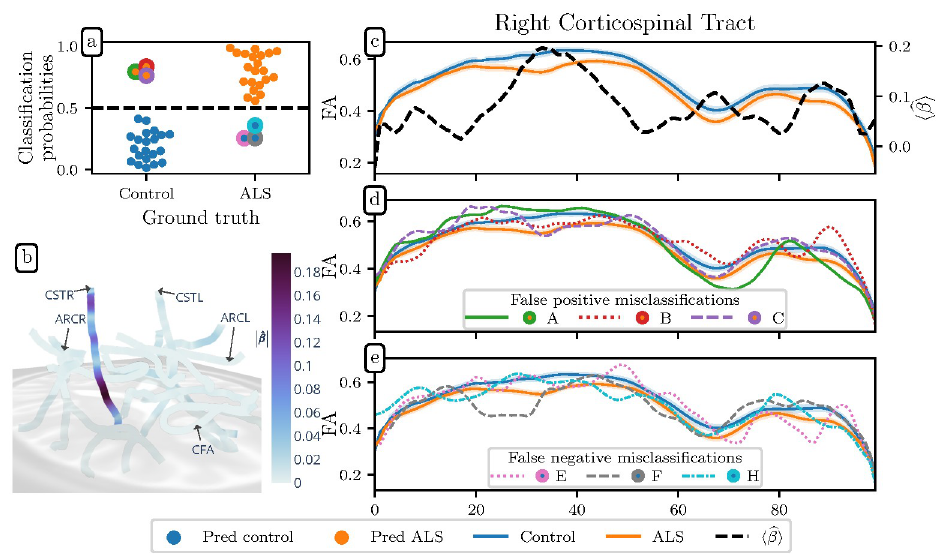
Fig 2. PCR-SGL accurately and interpretably predicts ALS diagnosis. (a) Classification probabilities for ALS diagnosis, with controls on the left, patients on the right, predicted controls in blue, and predicted patients in orange. That is, orange dots on the left represent false positives, while blue dots on the right represent false negatives. We achieve 83% accuracy with an ROC AUC of 0.88. (b) PCR-SGL coefficients are presented on the core fibers of major fiber bundles. They exhibit high group sparsity and are concentrated in the FA of the corticospinal tract (CST). The brain is oriented with the right hemisphere in the foreground and anterior to the right of the page. The CSTL, CSTR, callosum forceps anterior (CFA), left arcuate (ARCL), and right arcuate (ARCR) bundles are indicated for orientation. (c) PCR-SGL identifies three portions of the CST as important, where ^ b (dashed line, right axis) has large values. These are centered around nodes 30, 65, and 90, corresponding to locations of substantial differences in FA between the ALS and control groups (shaded areas indicates standard error of the mean). (d) Bundle profiles for false positive classifications. Line colors correspond to the marker edge color in the top left plot. These individuals have reduced FA in the CST portions which SGL identified as important. Their misclassification is coherent with the feature importance and the group differences in FA. (e) Individual bundle profiles for false negative classifications. These individuals have bundle profiles which oscillate between the group